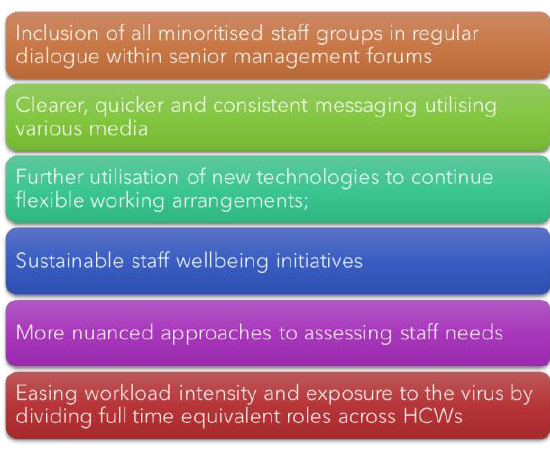
Figure 3. HCW recommendations adapted from [22].